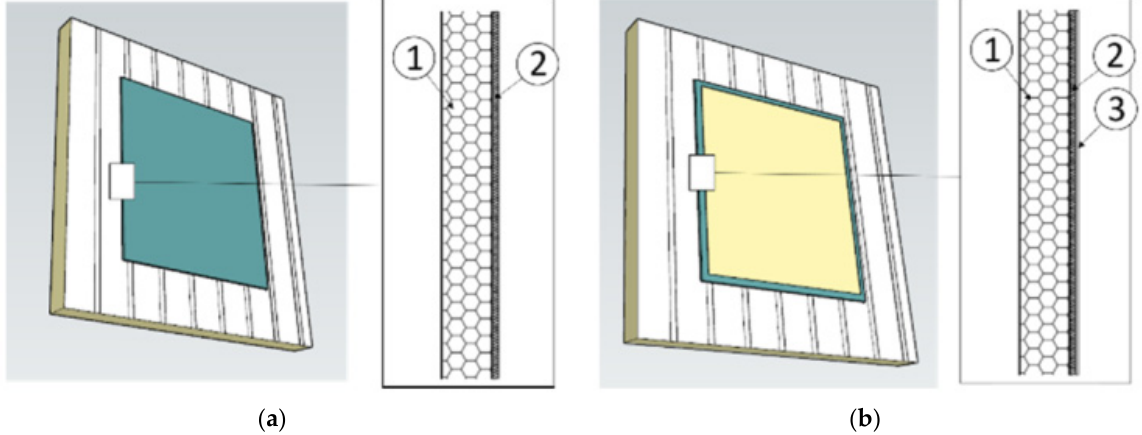
Figure 3. Schematic diagram of the indoor coating solutions applied to the 2 test cells. ( a ) DEMO1; reference cell with only WEDI ® panels (2) added to the base layer (1); ( b ) DEMO2; test cell with WEDI ® panels (1) + PCM-based mortar layer (3) added to the base layer (1). Source: [19].